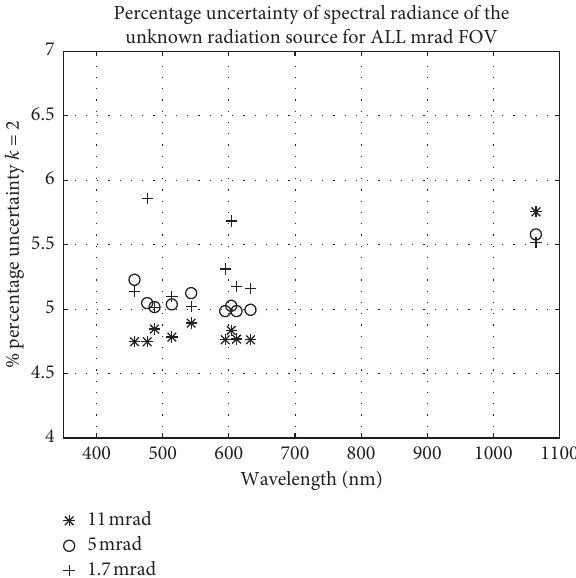
Figure 6: Percentage uncertainty distribution of spectral radiance of the unknown radiation source for all mrad FOV